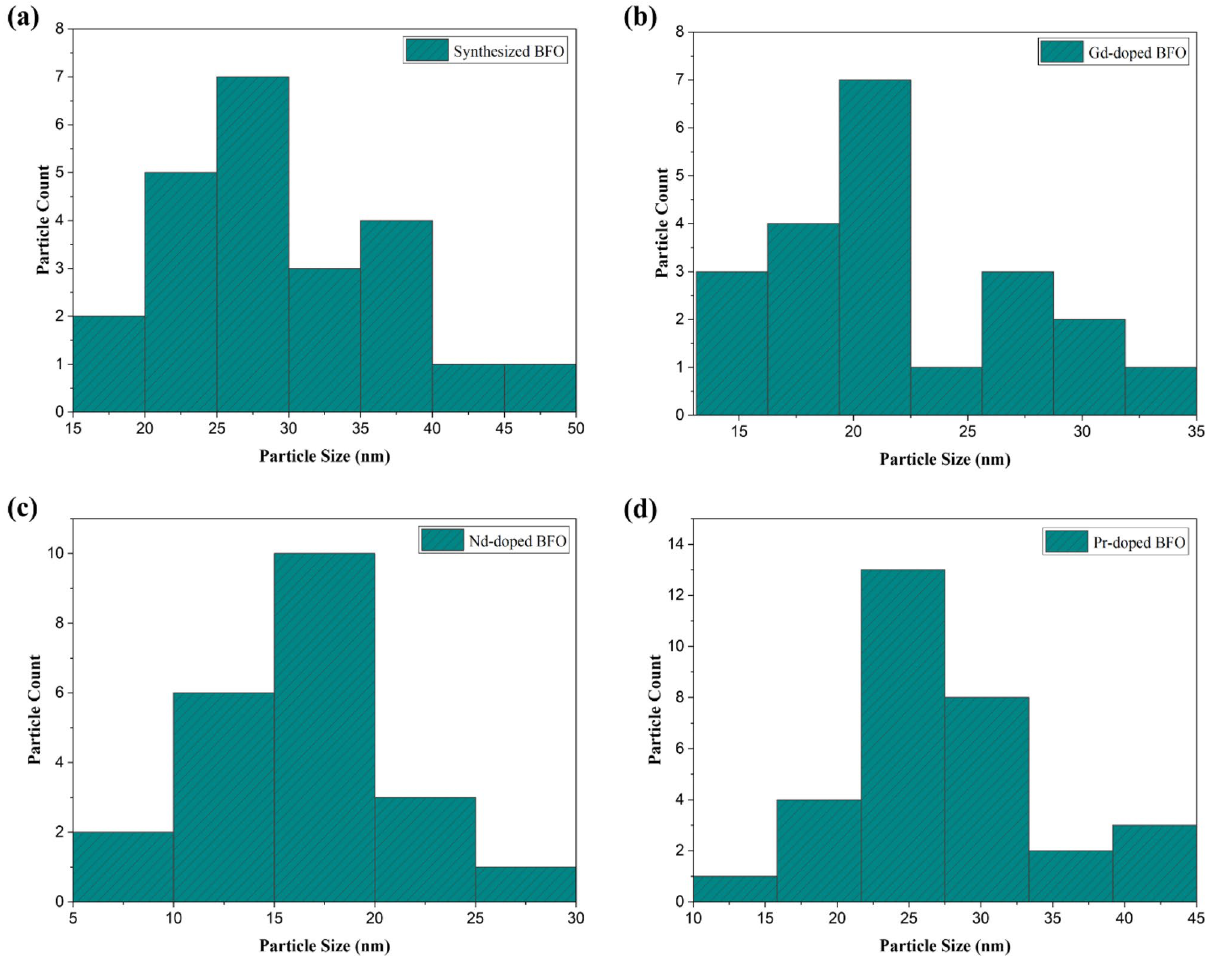
Figure 8. Particle size distribution of: ( a ) Synthesized BFO, ( b ) Gd-doped BFO, ( c ) Nd-doped BFO, and ( d ) Pr-doped BFO.